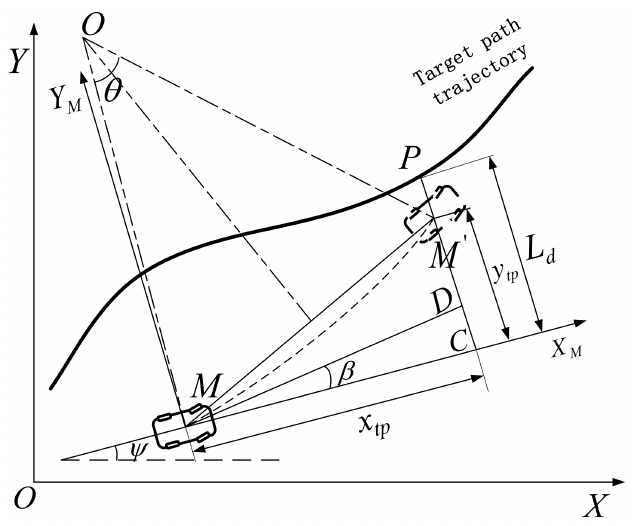
Figure 6. Preview tracking